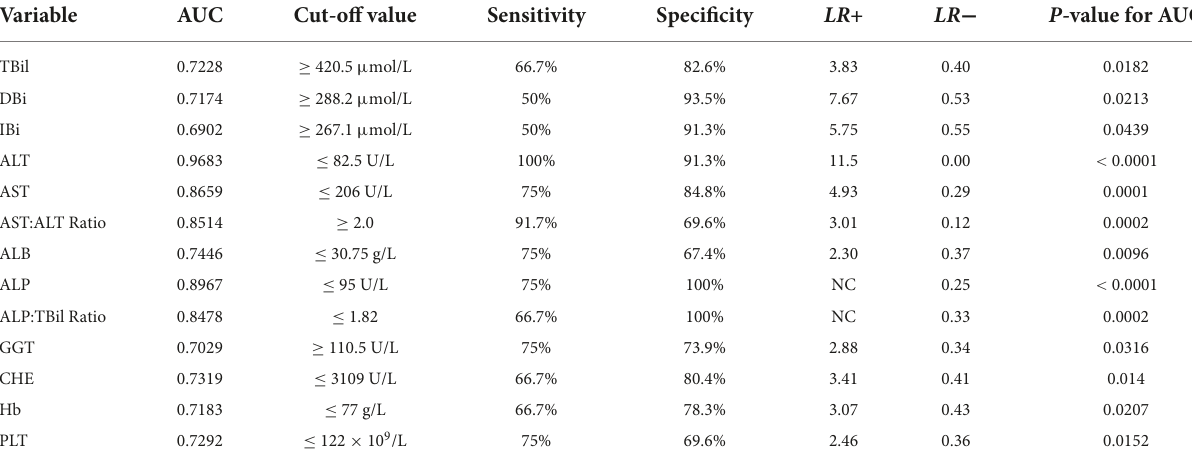
TABLE 5 Determination of the optimal cut-off points of laboratory tests for ALF-WD. Variable